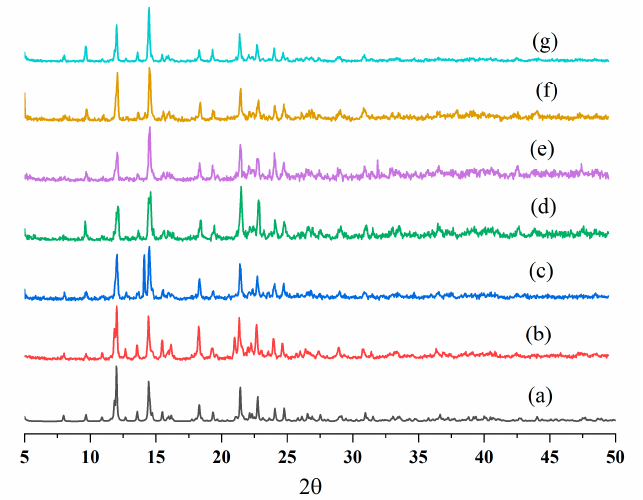
Figure 11. PXRD patterns before and after treatments with Fe 3+ ions for 8 . ( a ) Simulated, ( b ) experi- mental, ( c ) 1st cycle, ( d ) 2nd cycle, ( e ) 3rd cycle, ( f ) 4th cycle, and ( g ) 5th cycle.